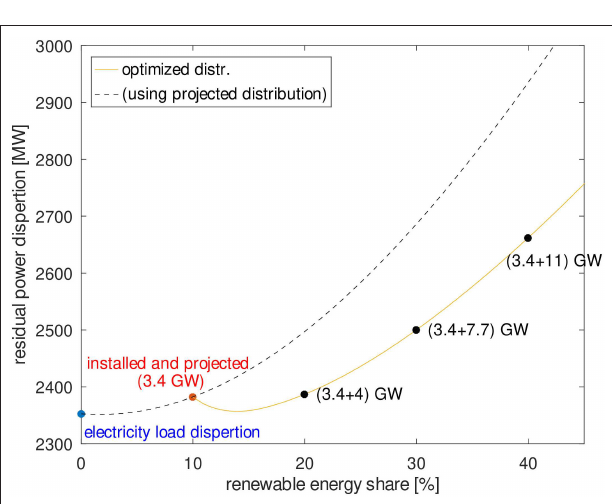
FIGURE 4 | Plot of the dispersion σ of residual power (electricity load minus renewables) in different scenarios: (dashed line) capacity with constant distribution as currently installed and projected; (solid line) future additional capacity optimized to diminish σ at each